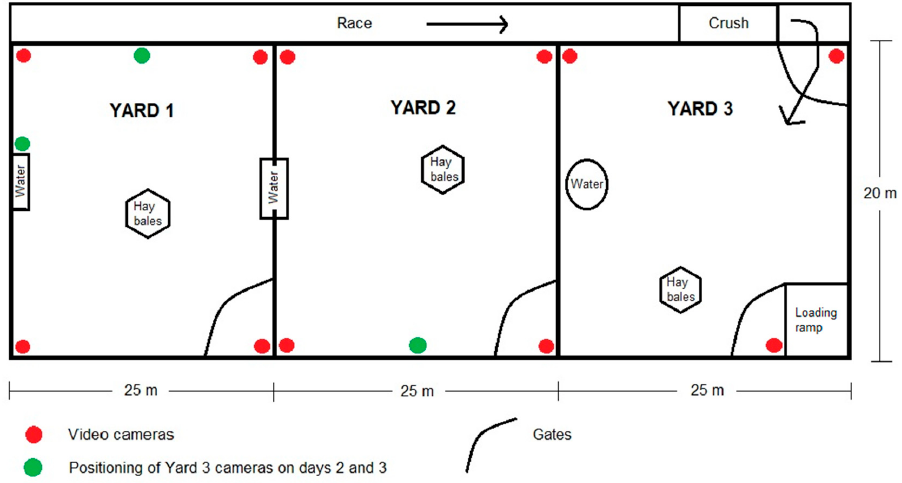
Figure 2. Model illustration of yard layout and video camera positioning.